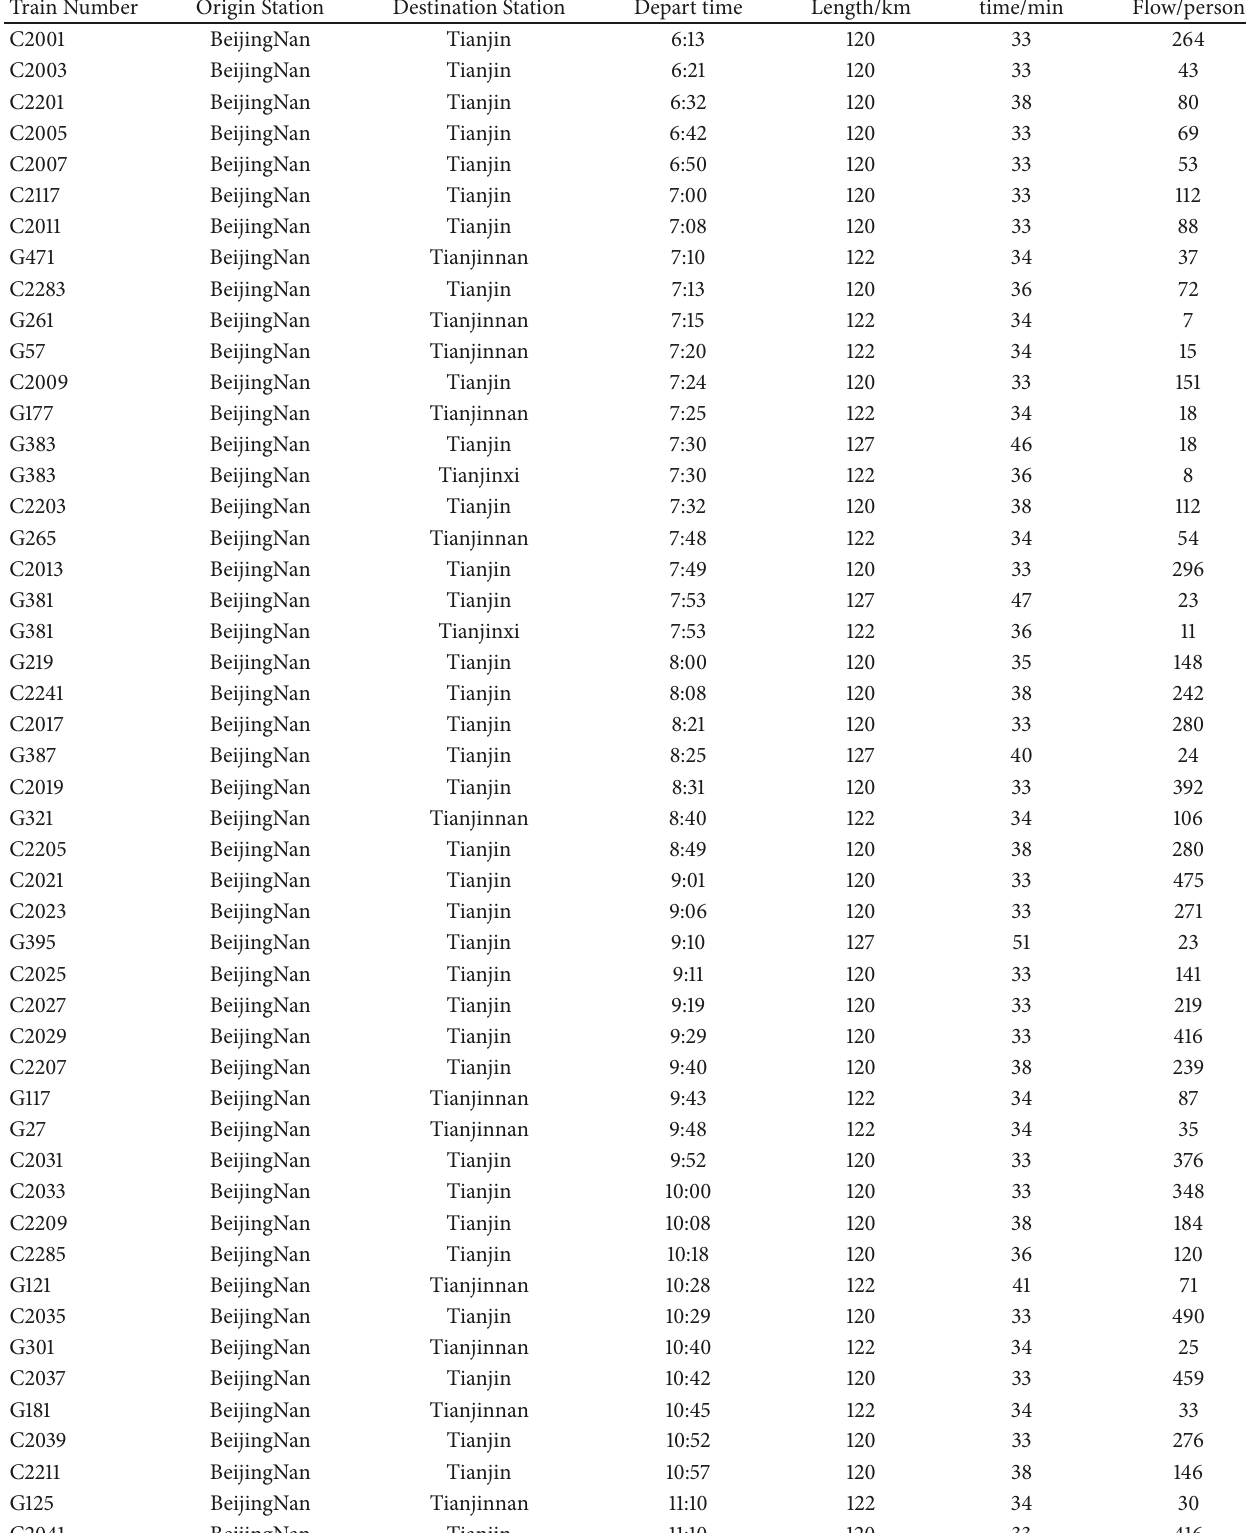
Table 12: The ticket booking data of each itinerary of OD pair Beijing-Tianjin on December 1 st 2015. Train